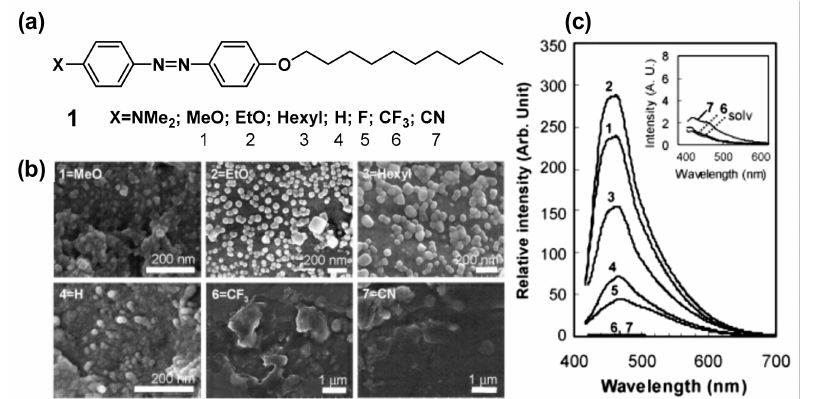
Figure 2. ( a ) The molecule structures of azobenzene derivatives 1 with different donor and acceptor substituents. ( b ) SEM images of 1 after UV irradiation for 300 min. ( c ) The fluorescence spectra of 1 . ( b , c ) were reproduced with permission from [50]. Copyright 2006 American Chemical Society.